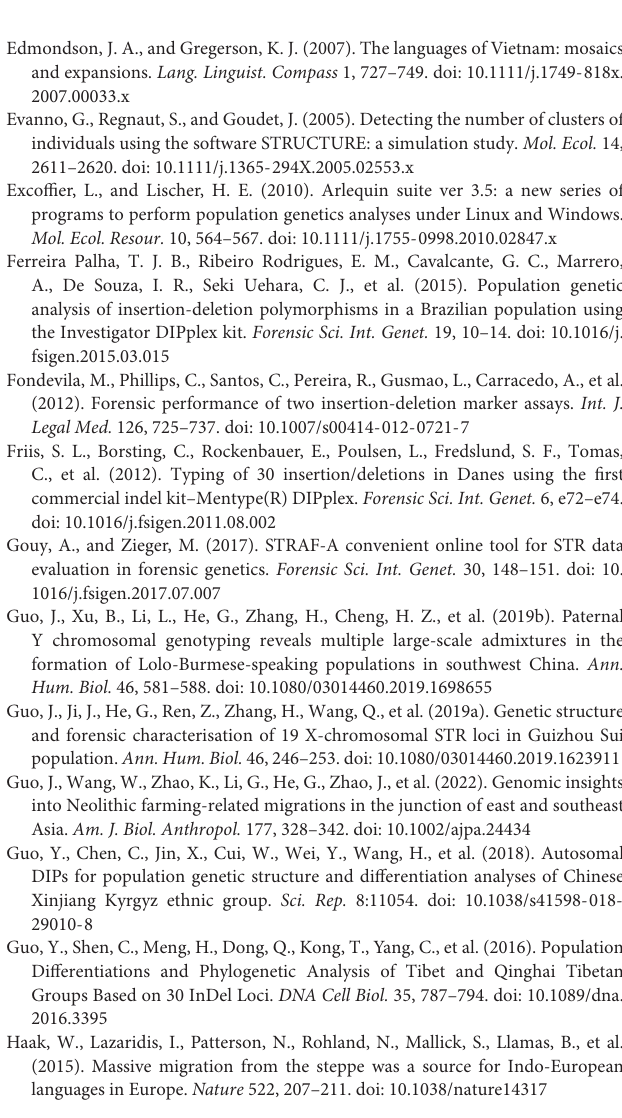
Guizhou Sui population. (C,D) Allele frequencies and corresponding forensic parameters of the 30 Indels in the Guizhou Sui population. Supplementary Figure 2 | The heat map on the basis of the deletion allelic frequency distributions for Guizhou Sui and 99 worldwide reference populations. Supplementary Figure 3 | The heat map of pairwise Nei’s genetic distances among Guizhou Sui and 99 worldwide reference populations. Supplementary Figure 4 | The heat map of pairwise D A genetic distances among Guizhou Sui and 99 worldwide reference populations. Supplementary Figure 5 | The results of ancestry component analysis on the 30 InDels with k ranging from 2 to 8 of the Guizhou Sui and 51 worldwide reference populations by STRUCTURE. Supplementary Figure 6 | The phylogenetic relationships between the Guizhou Sui population and modern Asian populations based on Treemix. Supplementary Figure 7 | The genetic affinity between Guizhou Sui and ancient populations in Asia. Significant Z scores were labeled by “ ++ ” “– –” ( Z > 6, Z < − 6, respectively), and Z -values with 3 < Z < 6, − 6 < Z < − 3 were labeled by “ + ,” “–,”